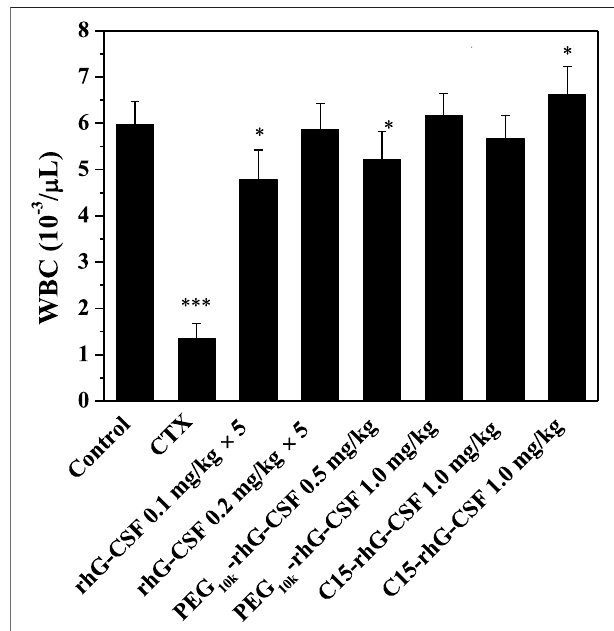
FIGURE 8 | Effects of rhG-CSF, PEG-rhG-CSF and C15-rhG-CSF on the WBC counts in CTX treated mice. The two-sided values of p p < 0.05, pp p < 0.01 and ppp p < 0.001 were considered signi fi cant for intergroup comparisons with the normal control